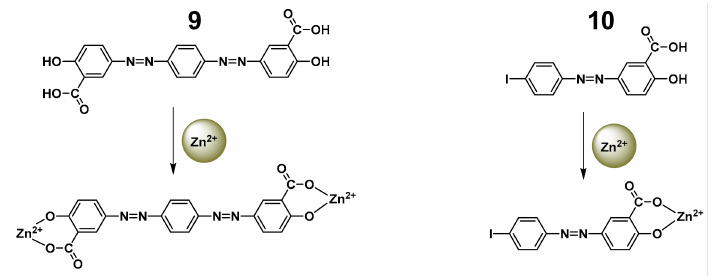
Figure 8. The molecular structure of azobenzene derivatives 9 and 10 which chelated with Zn 2+ .